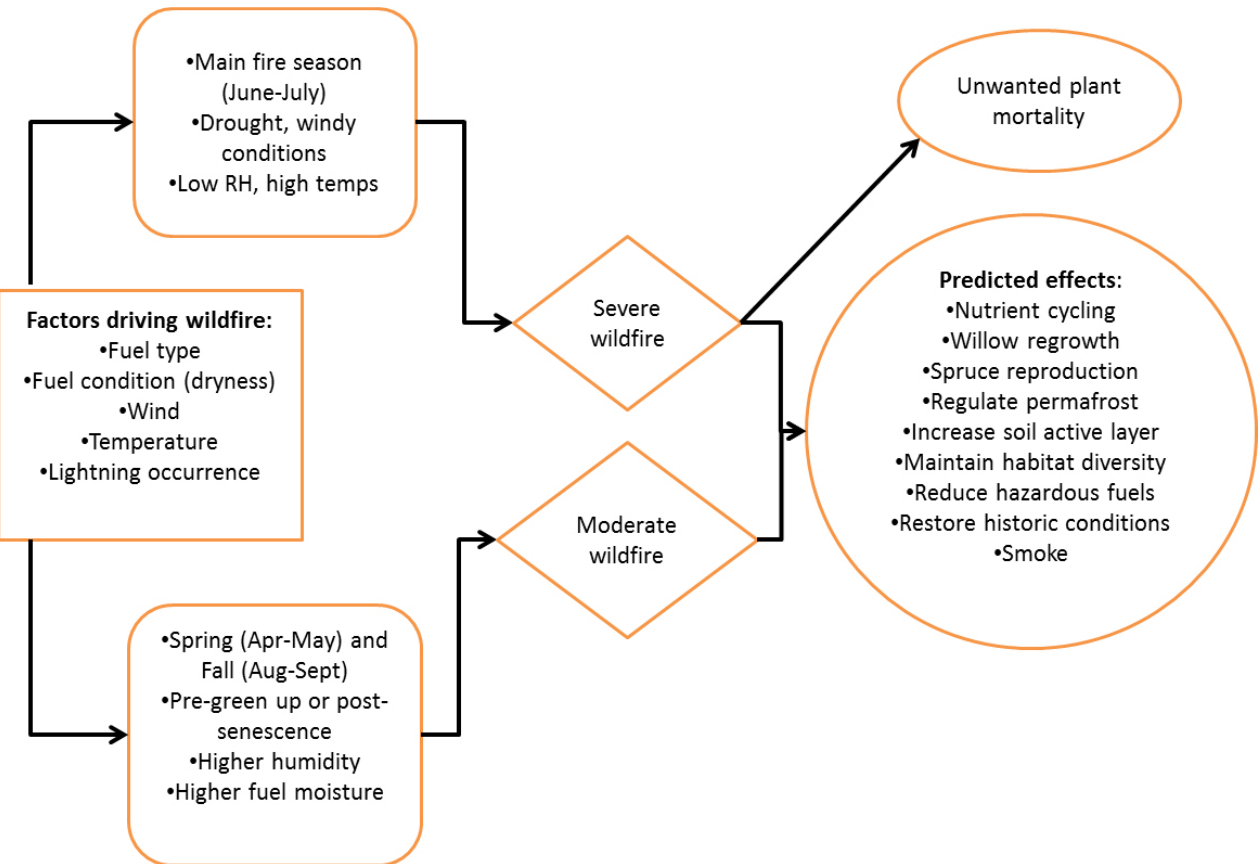
Fig. 10 . Description of factors driving wildfire severity and resultant effects on resources in the Koyukuk National Wildlife Refuge Fire Management Plan